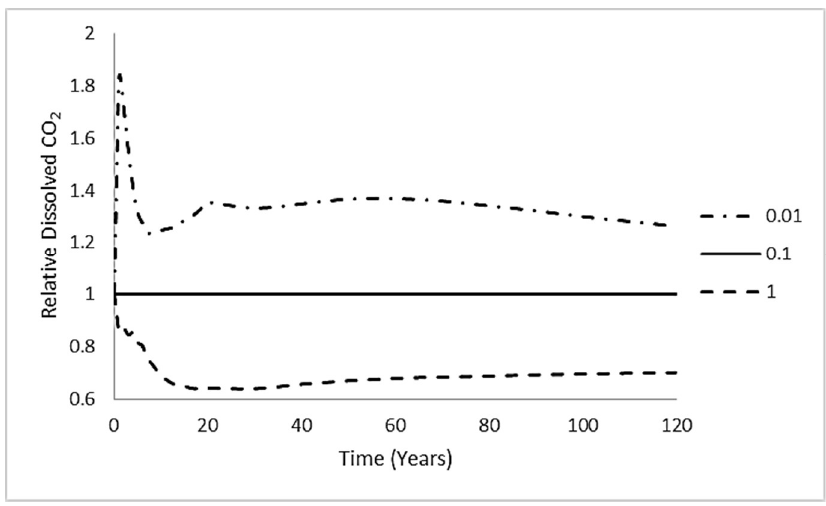
Figure 4. Simulation result for the effect of K v / K h ratio on CO 2 dissolution in brine vs. time by changing K h .